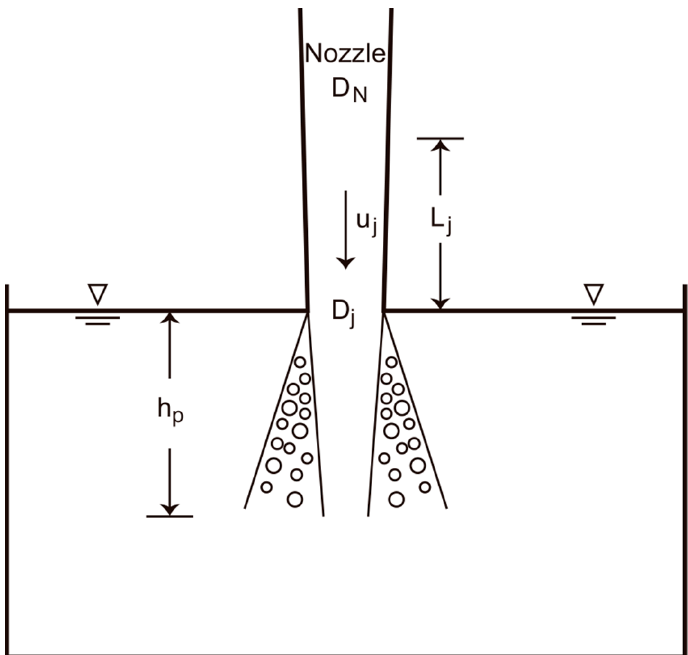
Figure 1. A schematic of a vertical plunging jet.